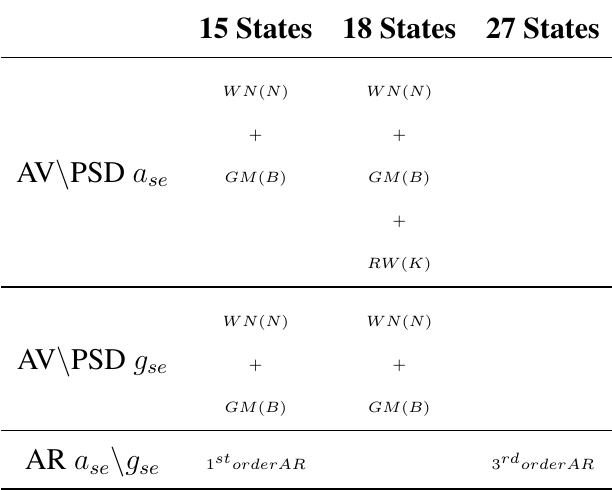
Table 8. Number of states in the loosely coupled integration architecture for different error models.